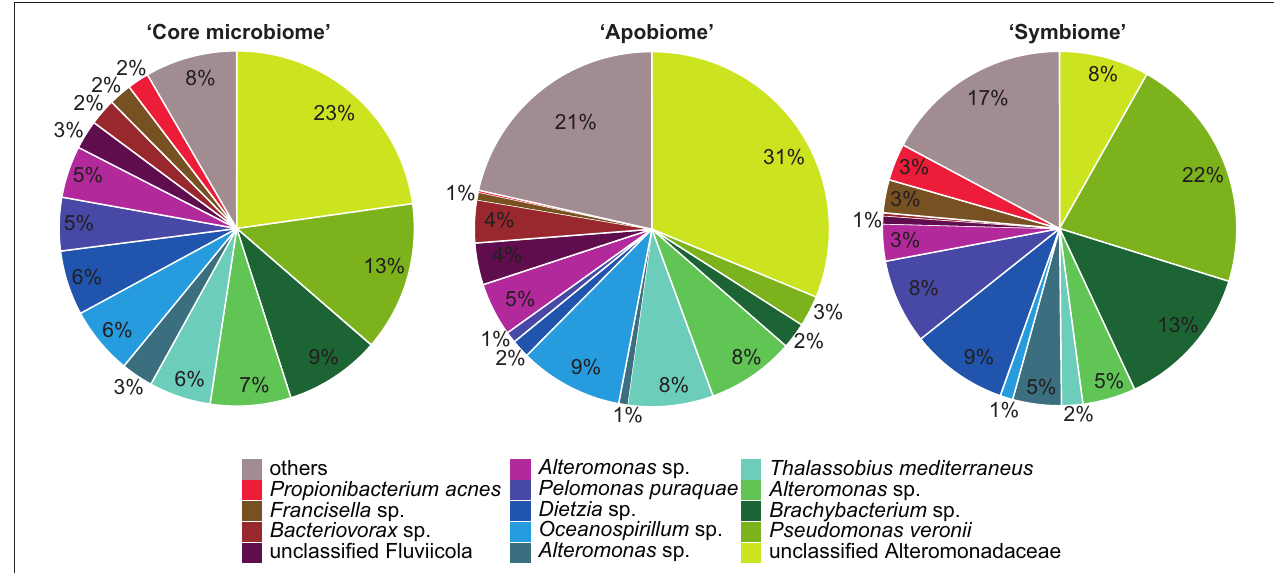
FIGURE 2 | Aiptasia “core microbiome”, “apobiome” (aposymbiotic microbiome), and “symbiome” (symbiotic microbiome). Bacterial members were determined by assessing presence of OTUs over samples. Only OTUs present in all anemones, all aposymbiotic anemones, and all symbiotic anemones were included in the “core microbiome”, “apobiome” (aposymbiotic microbiome), and “symbiome” (symbiotic microbiome), respectively. Each color represents a distinct OTU of the 14 most abundant taxa; 49 rare OTUs have been summarized in gray in the category “others.”